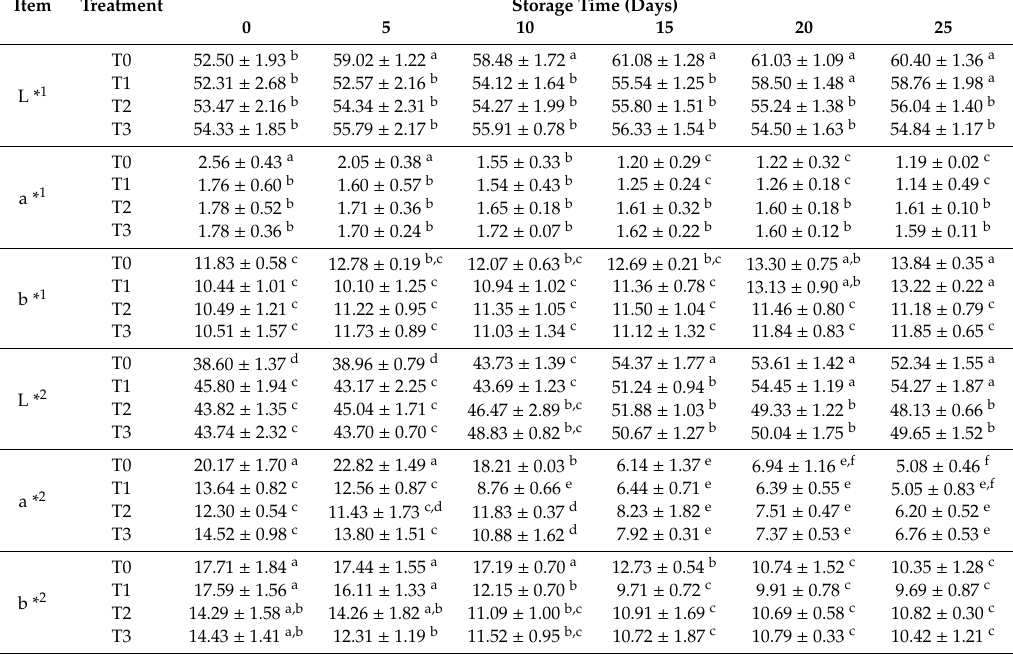
Table 2. E ff ects of treatments and storage time on colour changes in pork